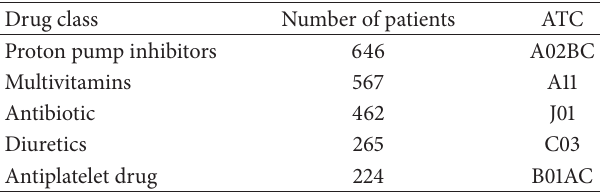
Table 2: Most commonly prescribed drugs.